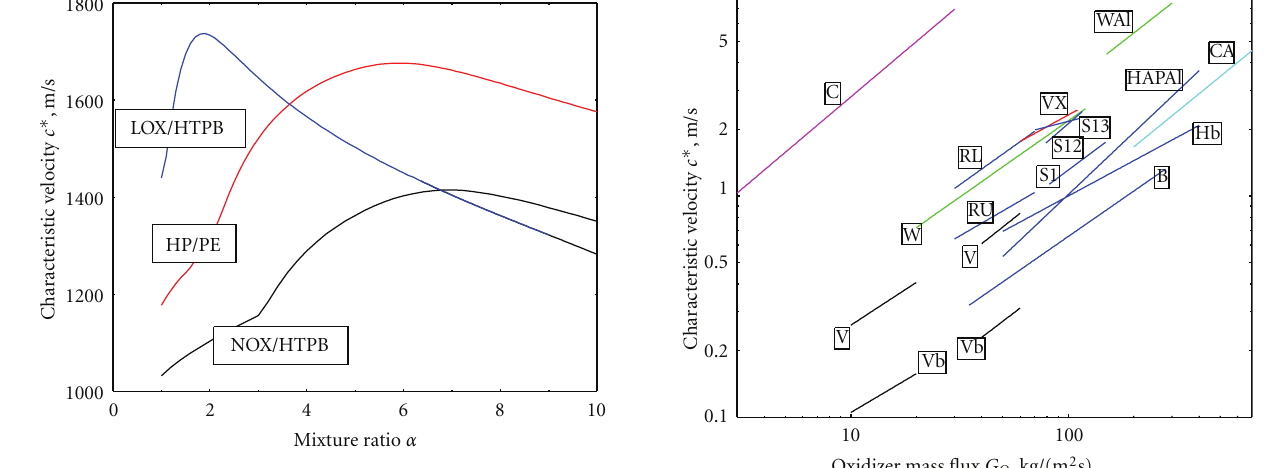
Figure 3: Theoretical values of characteristic velocity for di ff erent propellant combinationsm [3].